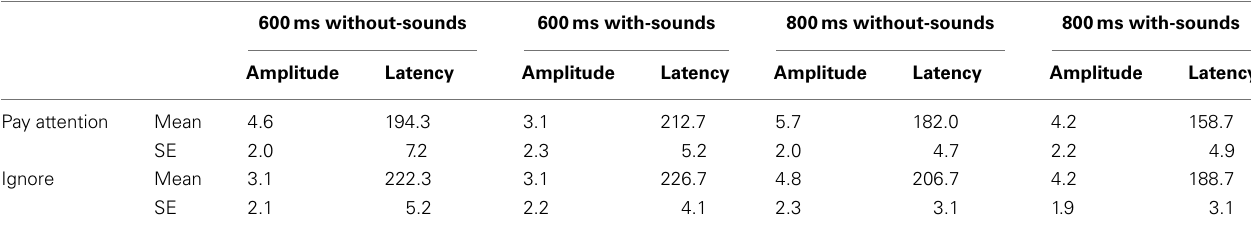
Table 2 | Mean amplitudes ( μ v) and latencies (ms) of P300 in each condition ( N = 12). 600ms without-sounds 600ms with-sounds 800ms without-sounds 800ms with-sounds Amplitude Latency